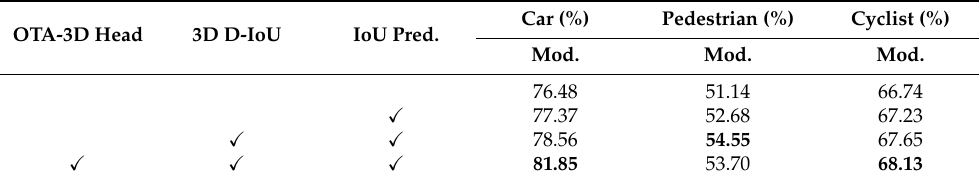
Table 8. Comparison of different strategies for the detection head. OTA-3D Head denotes the anchor-free head with the OTA-3D strategy. The AP is calculated with 11 recall points. Car (%) Pedestrian (%) OTA-3D Head 3D D-IoU IoU Pred. Mod.